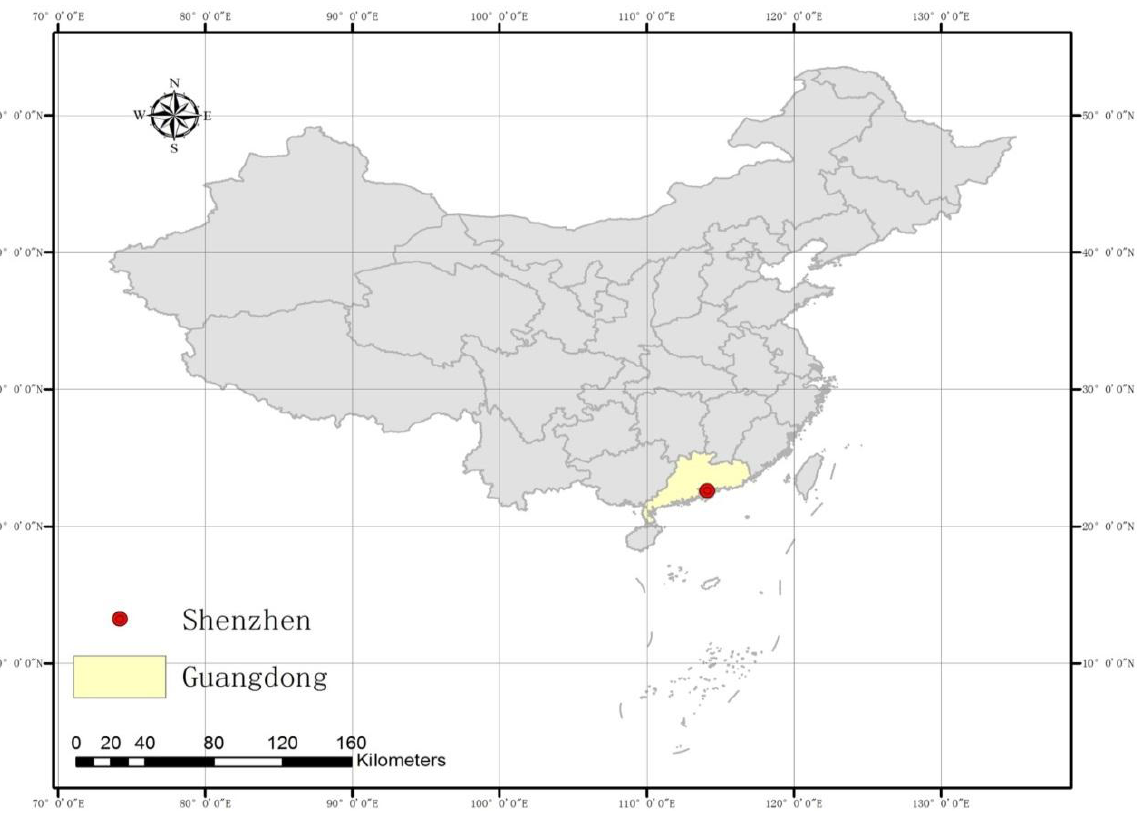
Figure 1. A map of China showing the location of